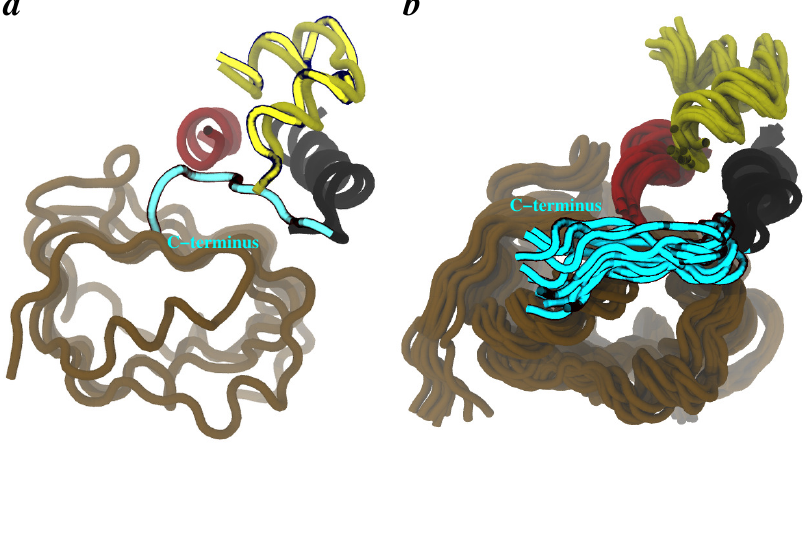
Conformation of the C-terminus of insulin B-chain. ( a ) Insulin conformation from our previous [61] structural model of insulin/IR ∆ β (brighter tubes) is overlayed on the insulin conformation in the hormone-bound crystal structure (darker tubes, PDB code 3W11). Alignment of insulin from both structures suggests new location of the separated C-terminus of insulin B-chain (cyan tube). ( b ) MD-equilibrated ensemble of L1/insulin/ α CT configurations from MDFF-generated model after incorporation of the C-terminus of the B-chain of insulin (cyan). Other domains of IR ∆ β are not shown for